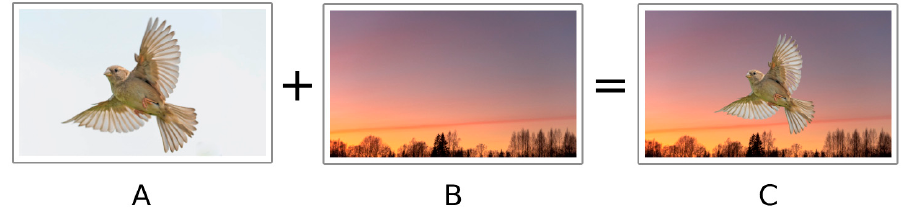
Figure 1. Represents the splicing of original images for obtaining a spliced image forgery, where ( A , B ) are the original images, and ( C ) is the spliced image forgery.